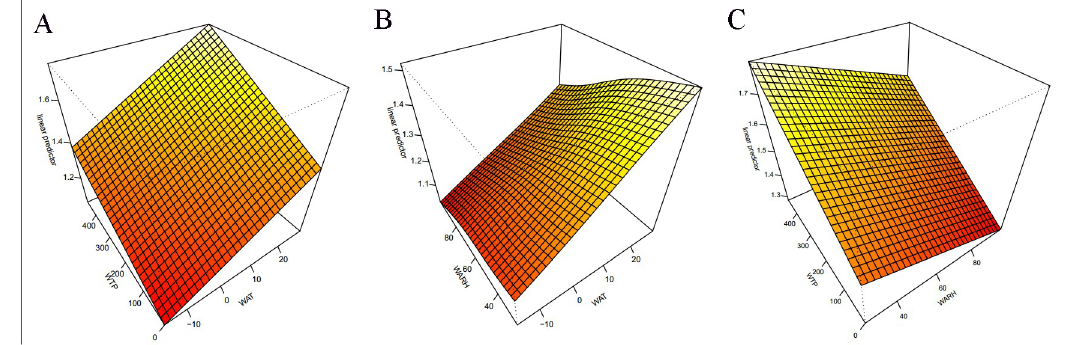
Fig 6. The effect interactions of the association among temperature, relative humidity, precipitation and HFRS in Huludao, 2007–2018. (Abbreviations: RR, relative risk; WAT, weekly average temperature; WTP, weekly total precipitation; WARH, weekly average relative humidity. A: the interaction effect between WAT and WTP; B: the interaction effect between WAT and WARH; C: the interaction effect between WARH and WTP).